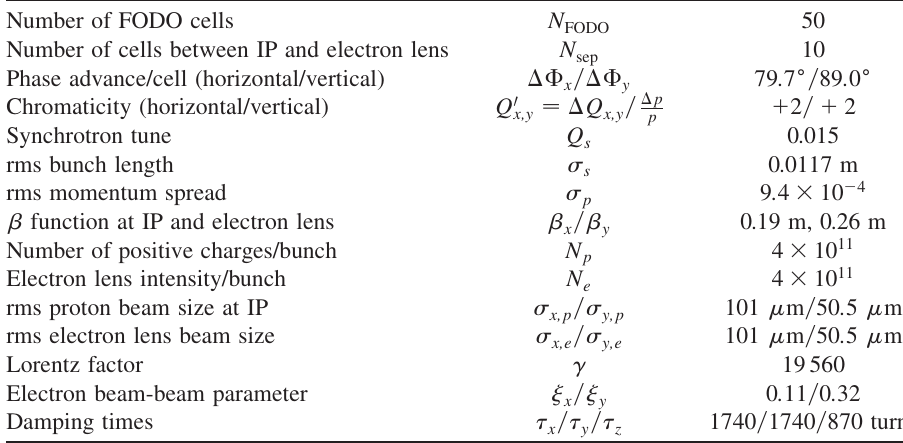
TABLE I. Parameter list of the accelerator model. (cid:1) functions and rms beam sizes at the IP and electron lens, as well as damping times, are taken from the eRHIC ring-ring design [1], while the proton beam intensity N p is